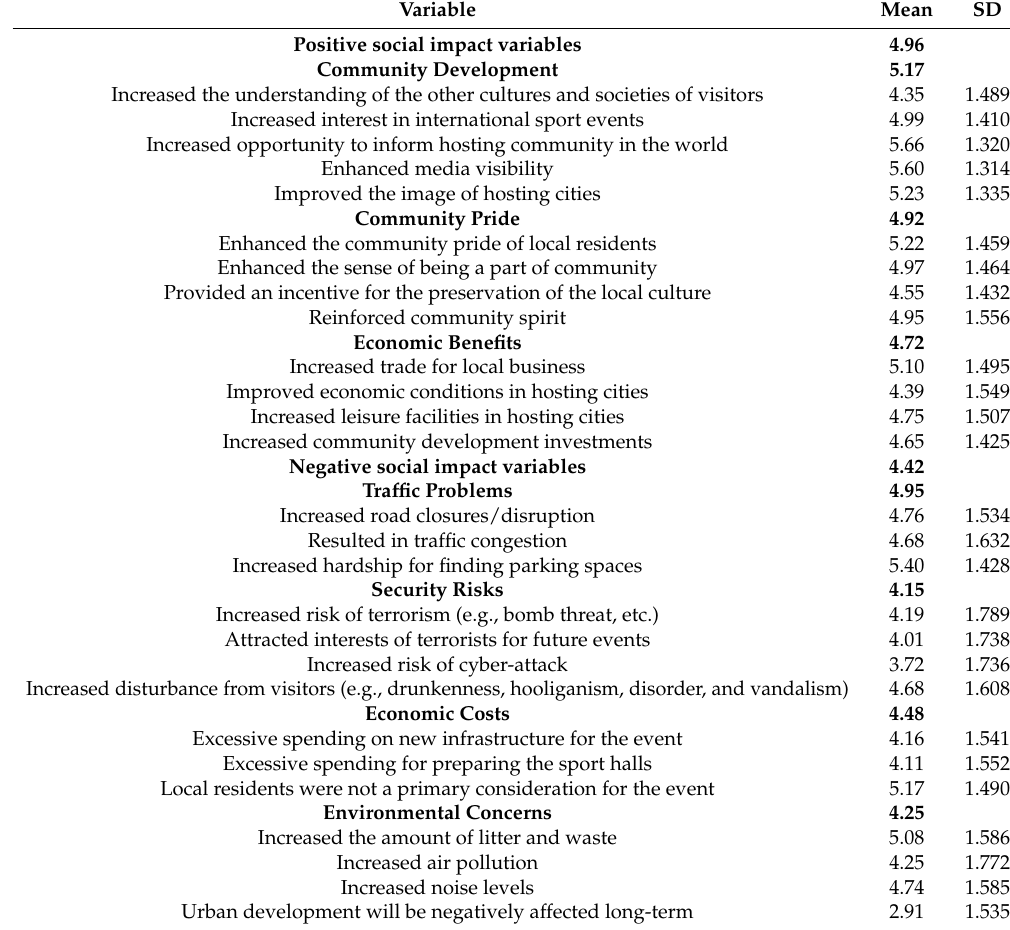
Table 2. Mean values and standard deviation for socio-economic impacts ( N =